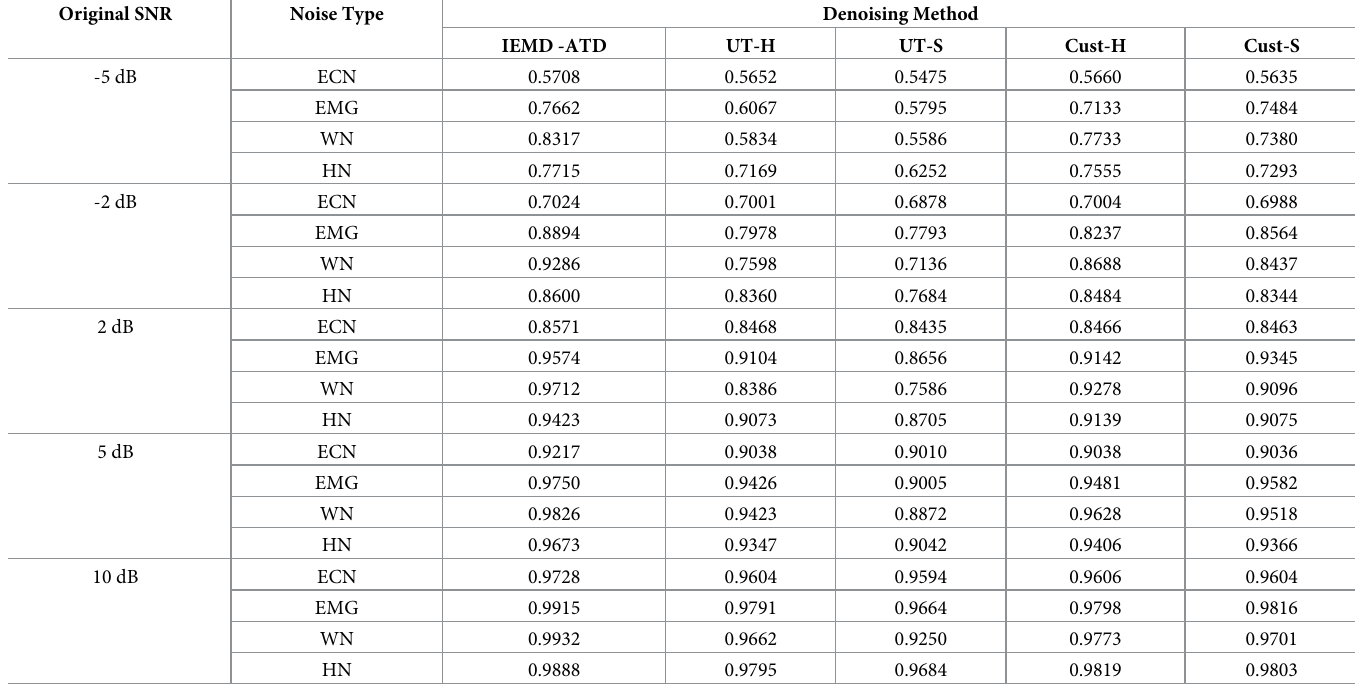
Table 7. Average correlation coefficient of 6 synthetic ECGs